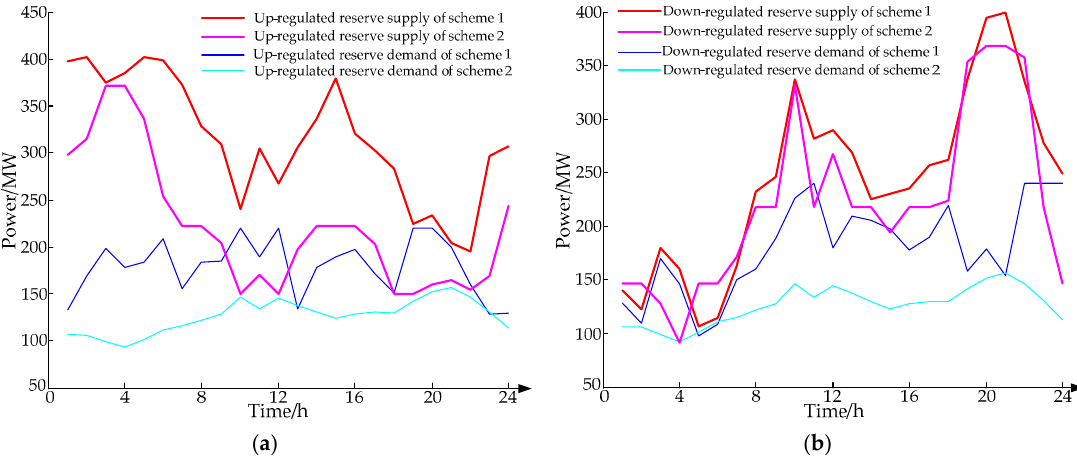
Figure 14. Comparison of reserve demand and supply under different schemes: ( a ) Up-regulated reserve comparison; ( b ) Down-regulated reserve comparison.